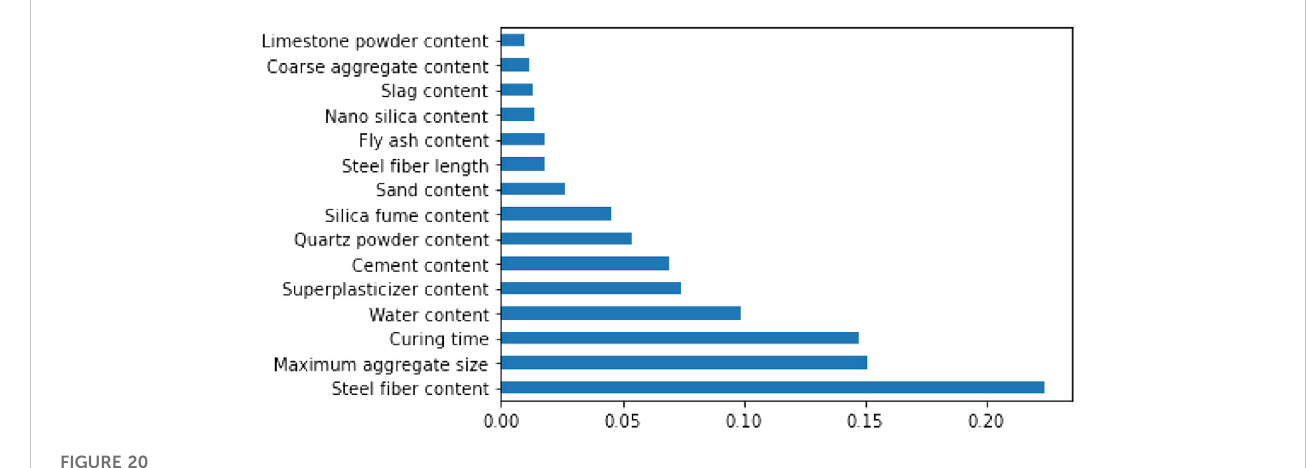
FIGURE 20 In fl uence of the input parameters towards the predicted output.